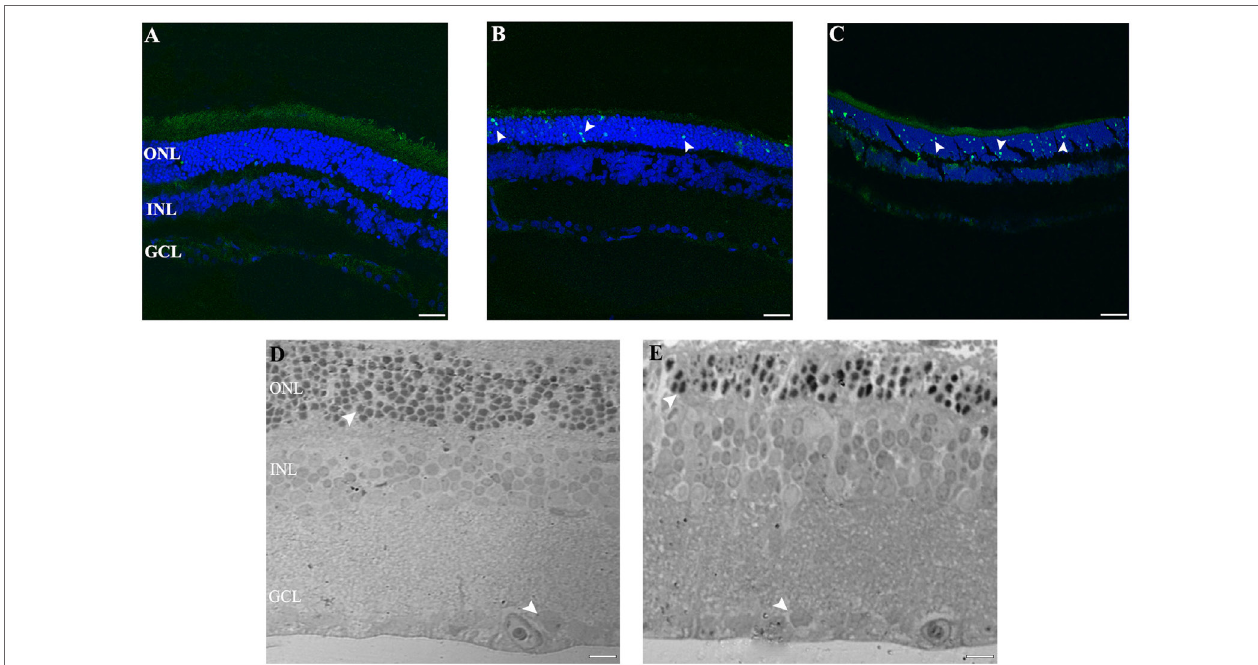
FigUre 2 | Cell death study in retinal light damage: (a–c) TUNEL staining at 2, 4, and 8 days of LL treatment, arrowheads show the TUNEL positive in the ONL. (D,e) Transmittance images of entire width of retina maintained in LD (D) and LL8 treated (e) , showing a clear reduction in ONL after 8 days of LL stimuli; normal (D) and pyknotic nuclei (e) in the ONL and normal nuclei in GCL (D,e) . Scale bar indicates 30 µm. ONL, outer nuclear layer; INL, inner nuclear layer; GCL, ganglion cell